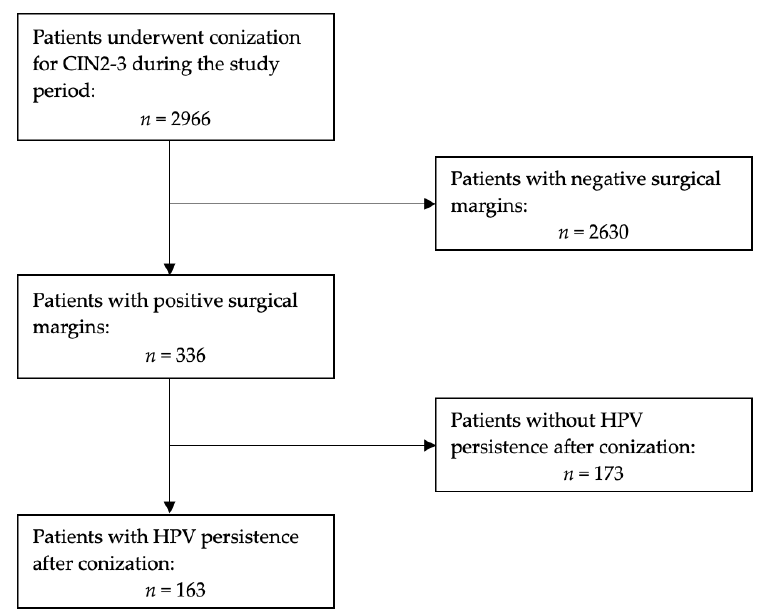
Figure 1. Flow of patients thorough the study design.